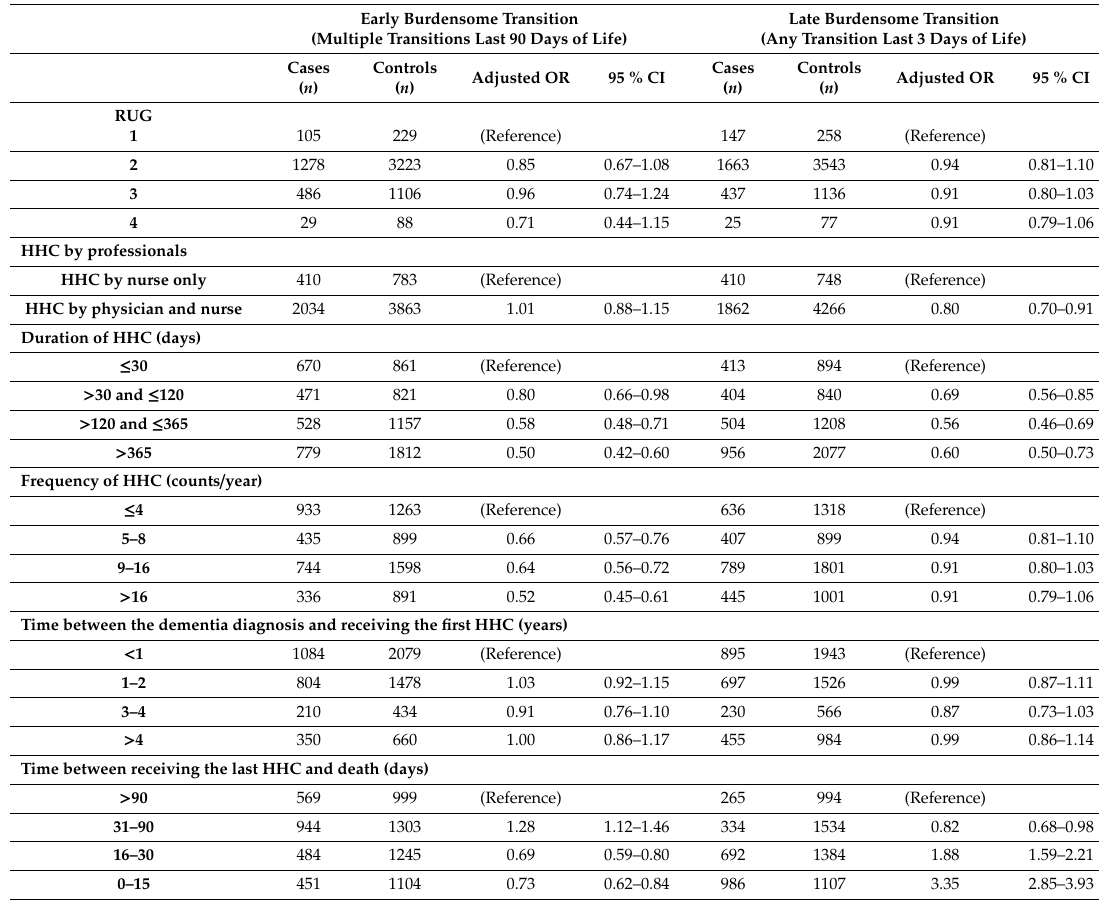
Table 2. Subgroup analysis of burdensome end-of-life transition in people with dementia who received home healthcare stratified by the characteristics of home